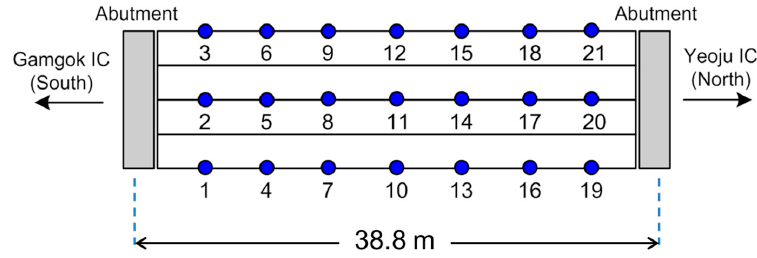
Figure 5. Location of accelerometers in ambient vibration tests.